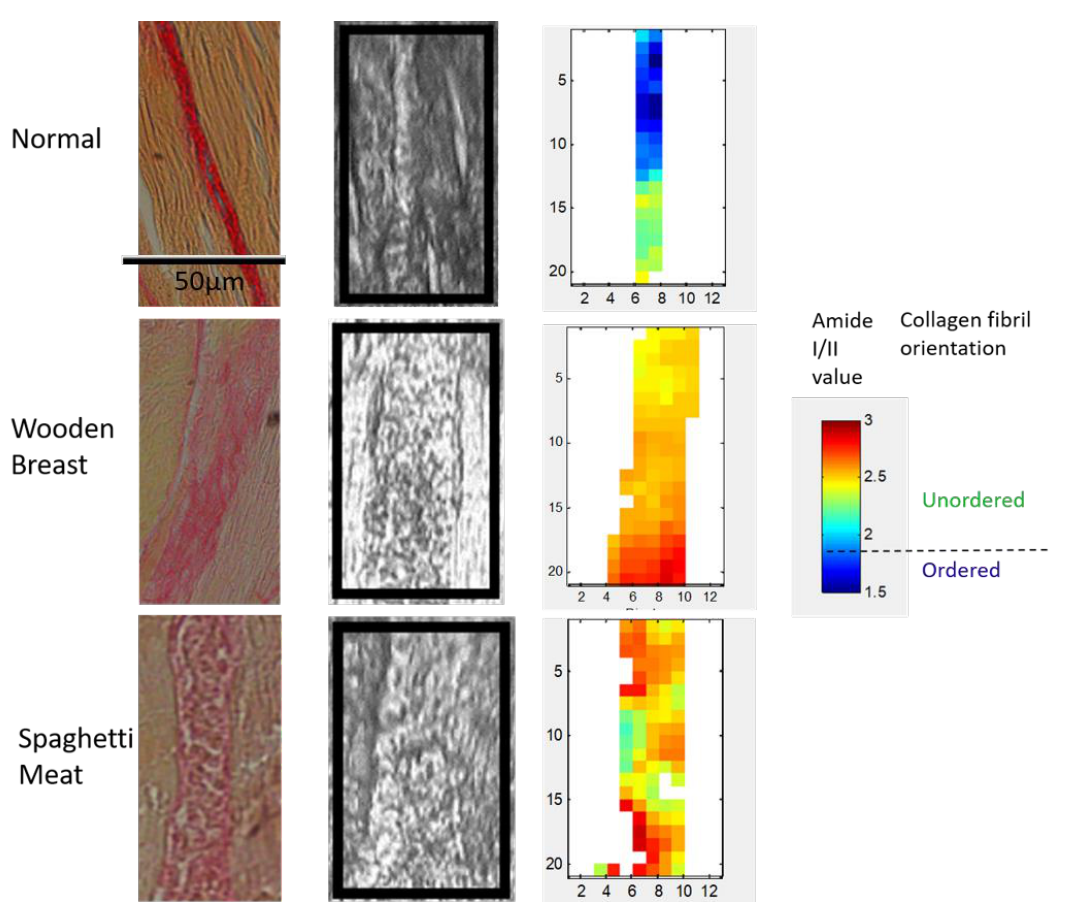
Figure 6. ( Left ): a picrosirius red-stained image of a longitudinal section of NO, WB, and SM connective tissue, ( middle ): light microscopy image, and ( right ): the corresponding polarized FTIR images calculated from the ratio amide I/amide II. Low ratios values (blue-green color) indicate more ordered fibers and high values (yellow-red) less ordered fiber organization.